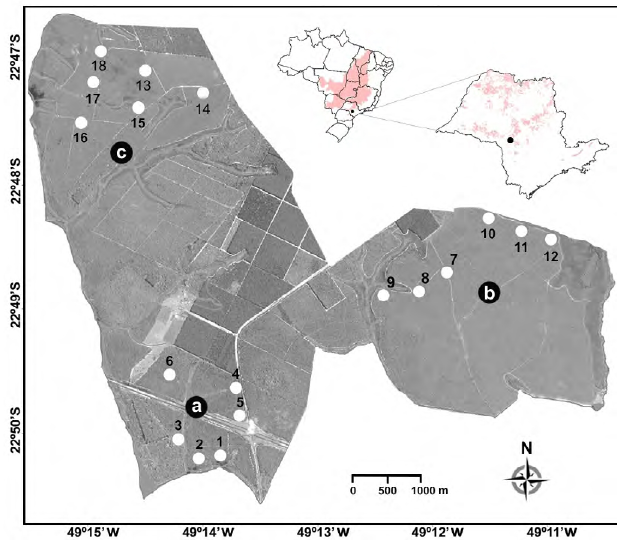
Original extent of the Cerrado in Brazil and the state of São Paulo (the black dot represents the Estação Ecológica de Santa Bárbara). The aerial photograph shows pitfall traps (white dots) installed in the forested site (a) and open sites (b,